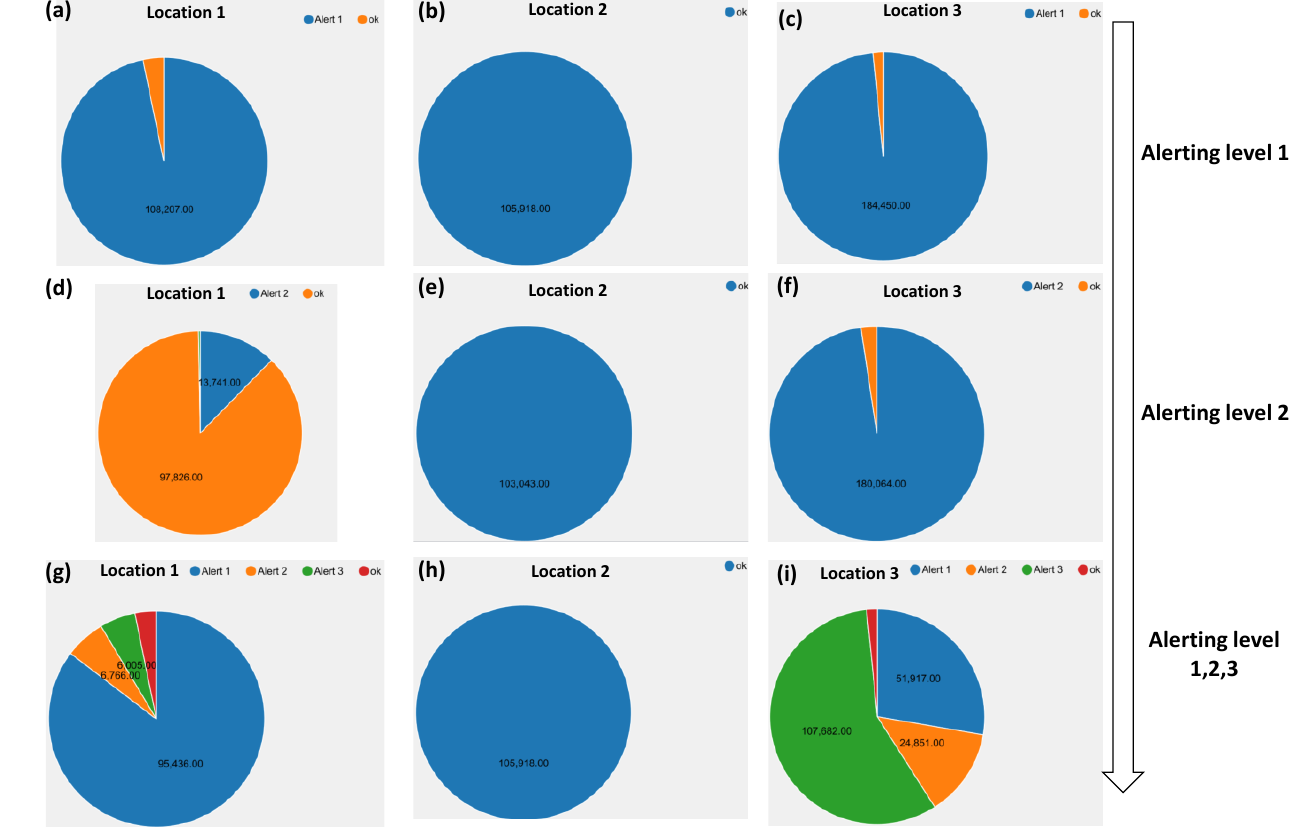
Figure 4. KNIME dashboards (output of the “Pie/Donut charts” blocks of the KNIME workflow of Figure 1). Alerting level 1 dashboards of location 1 ( a ), location 2 ( b ), and location 3 ( c ). Alerting level 2 dashboards of location 1 ( d ), location 2 ( e ), and location 3 ( f ). Alerting level 3 dashboards and summary of other alerting levels of location 1 ( g ), location 2 ( h ), and location 3 ( i ).